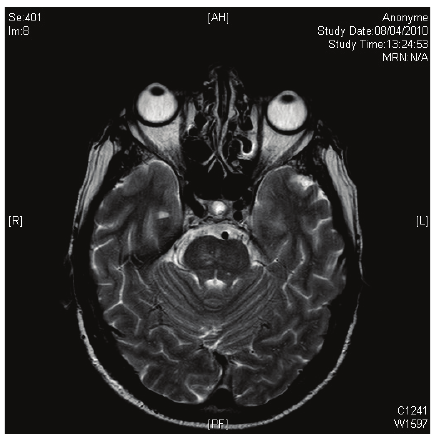
Figure 1: Thoracic imaging by computed tomography (CT)revealed a left hilar mass with associated left hilar and mediastinal lym- phadenopathy.